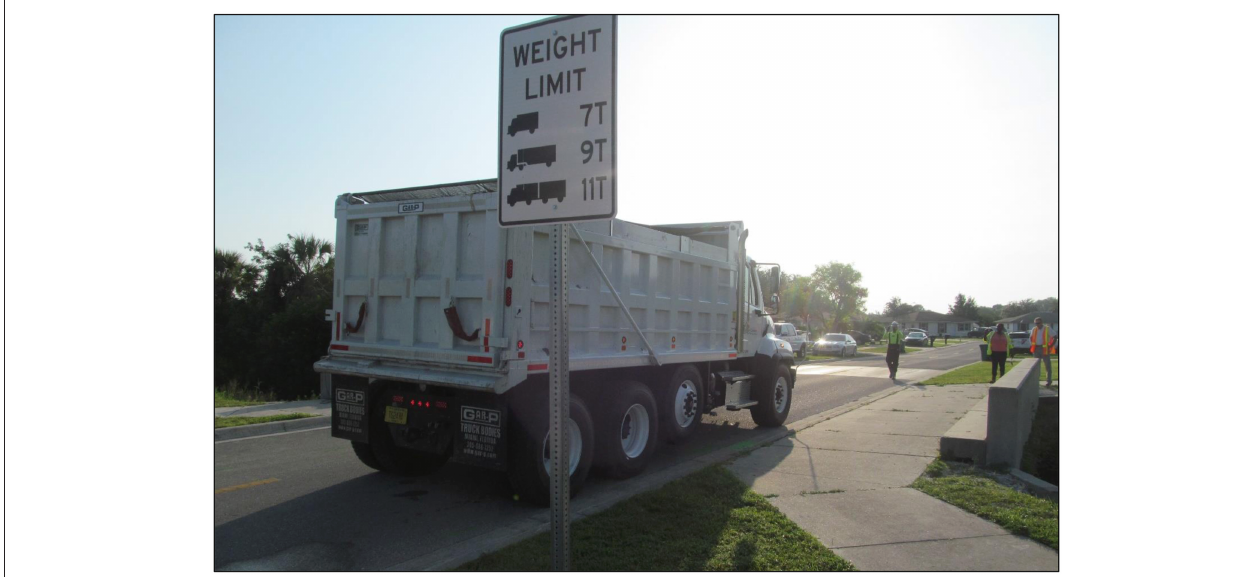
FIGURE 1 | Controlled load test on a posted local access bridge.